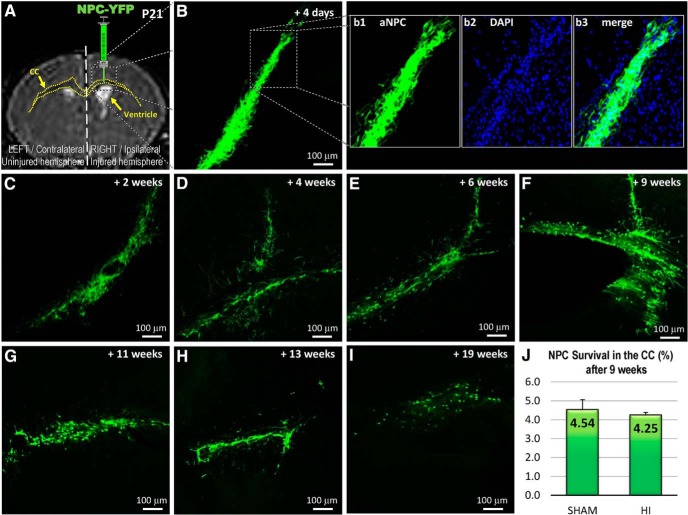
Transplanted NPCs survive, migrate, differentiate morphologically, and integrate within the corpus callosum. At P21, injury is visible by MRI and includes the thinning of the CC (outlined in yellow) and a right ventriculomegaly. A, NPCs were transplanted in the right/ipsilateral/injured CC at PND21. B–I, The NPCs migrated and spread through the CC. Their morphology changed from a round-type (in vitro) to a fibroblast-like cell type and, subsequently, to a cell with multiple processes. I, Transplanted NPCs (green) are counterstained by DAPI (blue; b1–b3). The NPCs survived >19 weeks after transplantation. J, The survival rate was similar in the HI and sham animal after 9 weeks.